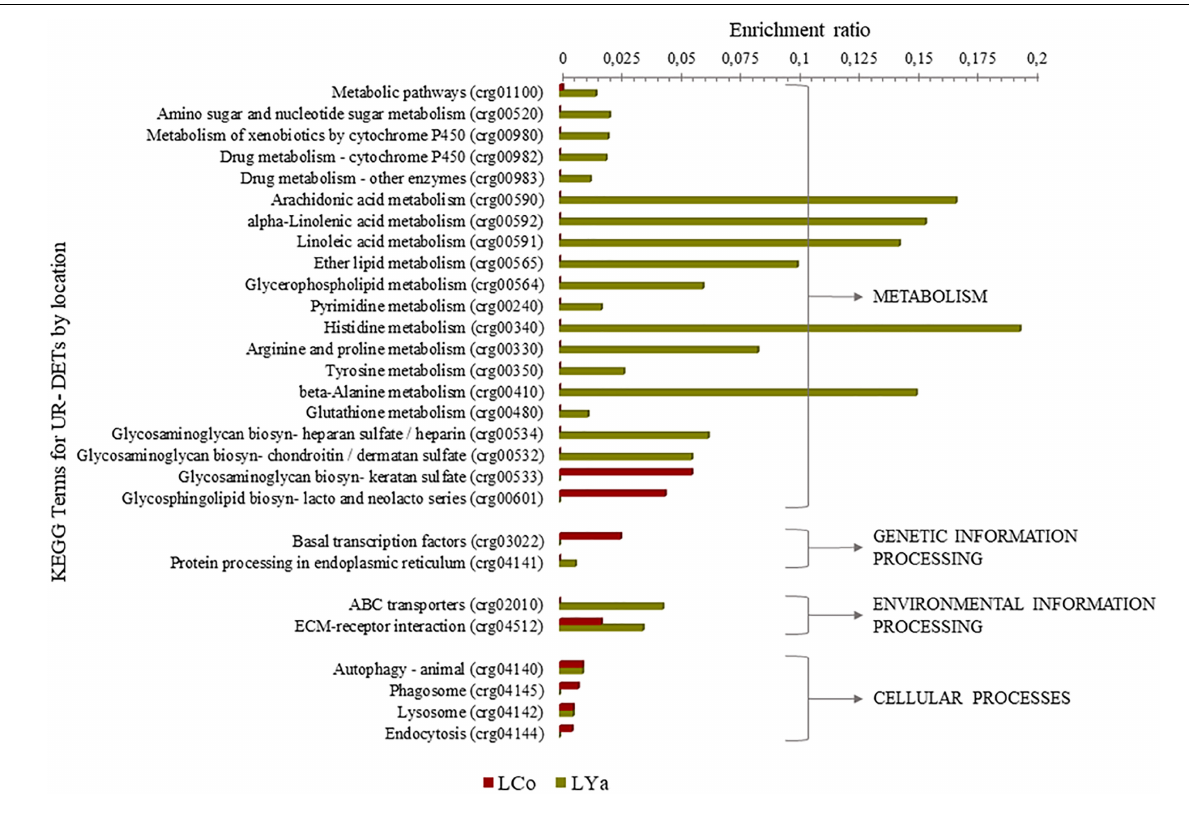
FIGURE 8 | KEGG categorization of the differentially expressed transcripts (DETs) of the comparison by location. LCo, local individuals from Cochamó and LYa, locals from